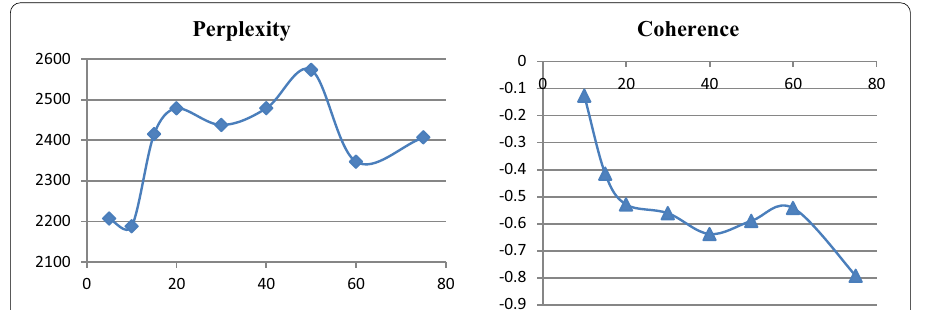
Fig. 2 Grid search on perplexities (left) and semantic coherences (right) in topic model